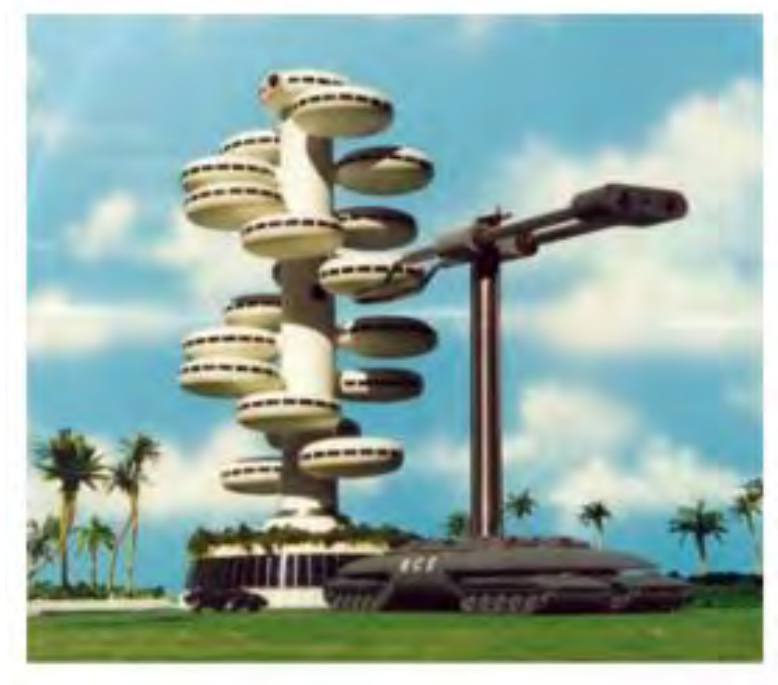
Figure 15. Multi-function unit. Source (Fresco, 2007)